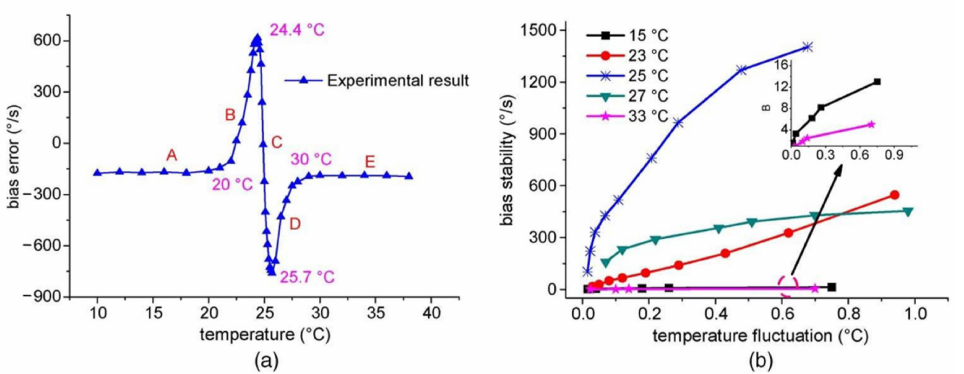
Figure 14. Experimental findings of ( a ) bias error of the RIOG in different temperatures and ( b ) bias stability of the RIOG in different temperature fluctuations. Reprinted with permission from ref. [43]. Copyright 2012 IEEE.